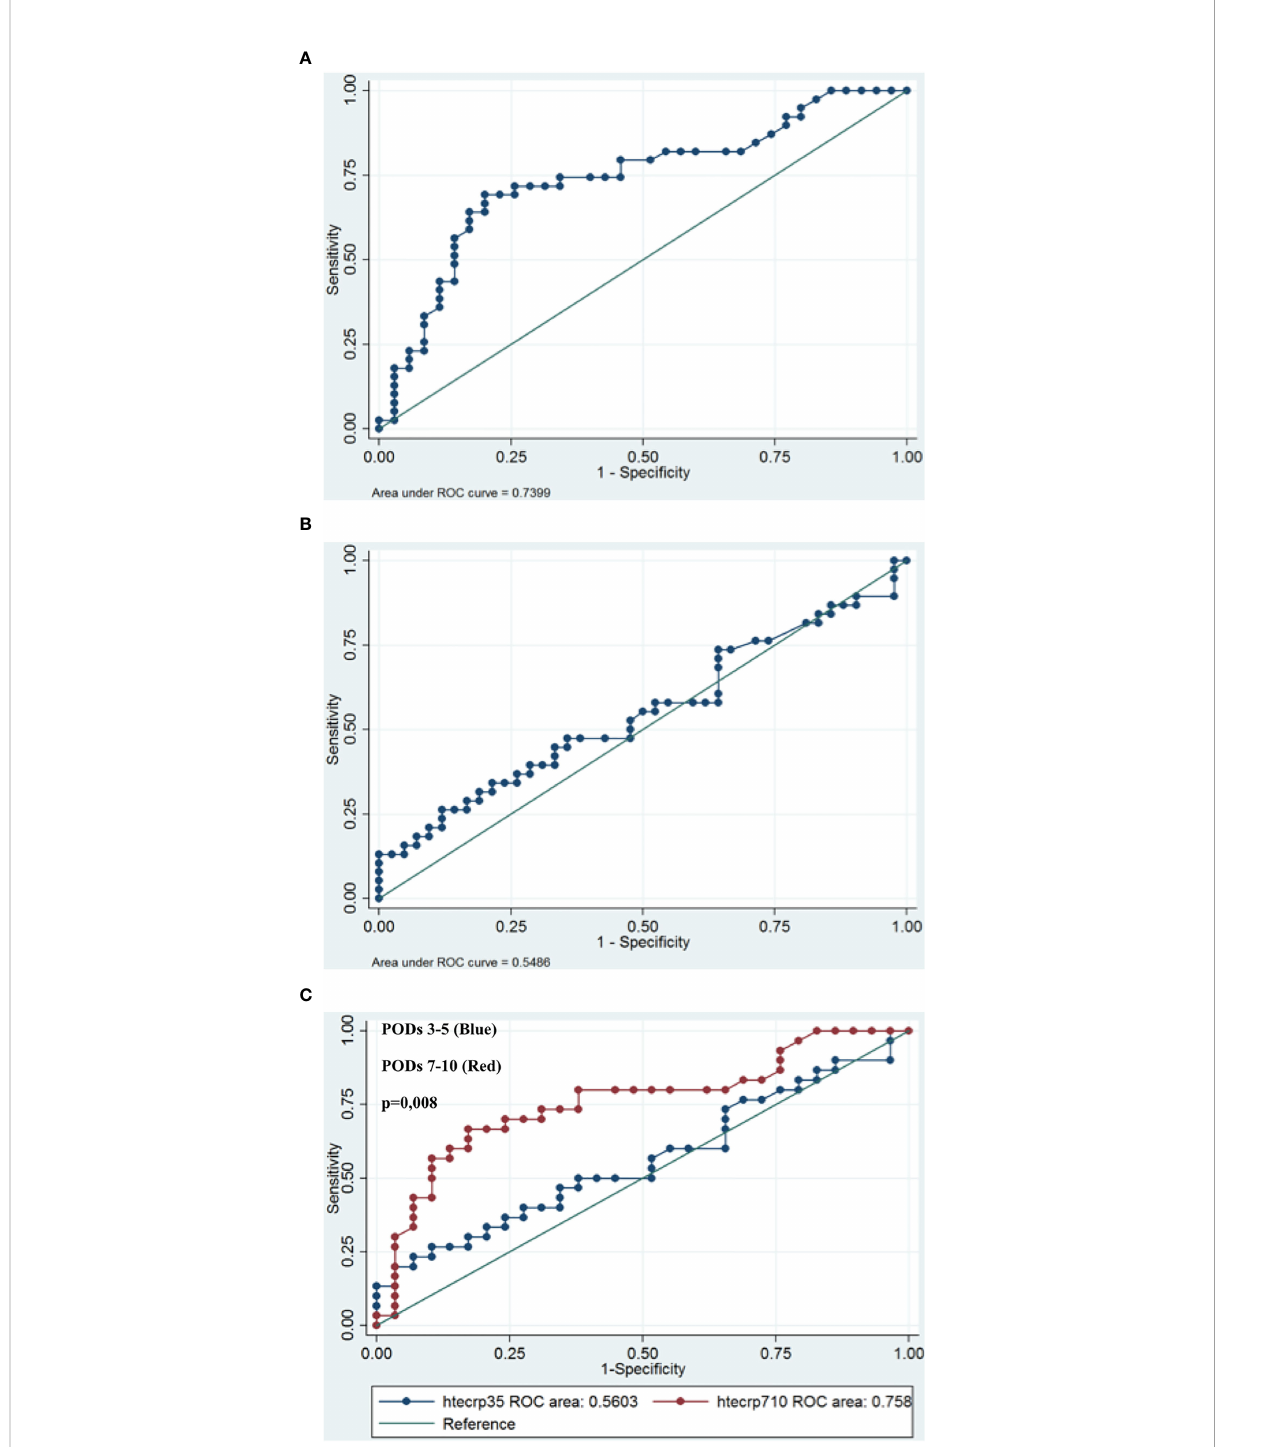
FIGURE 3 Receiver operating characteristic (ROC) curves for CRP on postoperative day (PODs) 3-5 (A) and PODs 7-10 (B) for patients with infective complications. An investigation of cut-off scores showed that the optimal CRP cut-off value was 169 mg/l on PODs 3-5 (sensitivity 26.3%; speci fi city 88.1%) and 62 mg/l on PODs 7-10 (sensitivity 69.2%, speci fi city 80%). The area under the ROC curve was 0,56 on PODs 3-5 and 0,76 on POD 7-10, p=0.0071 (C)